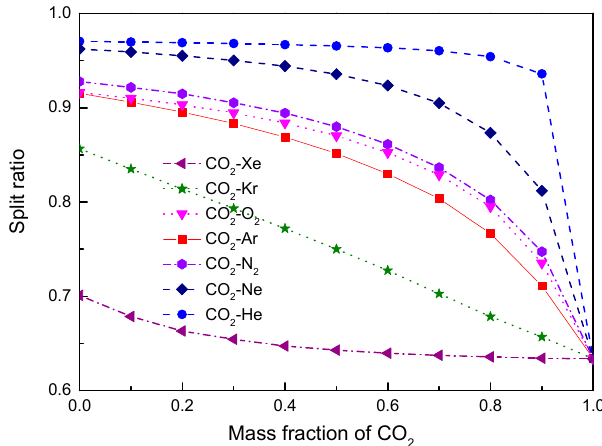
Figure 18. Split ratio of mixtures at different mass fractions of CO 2 .